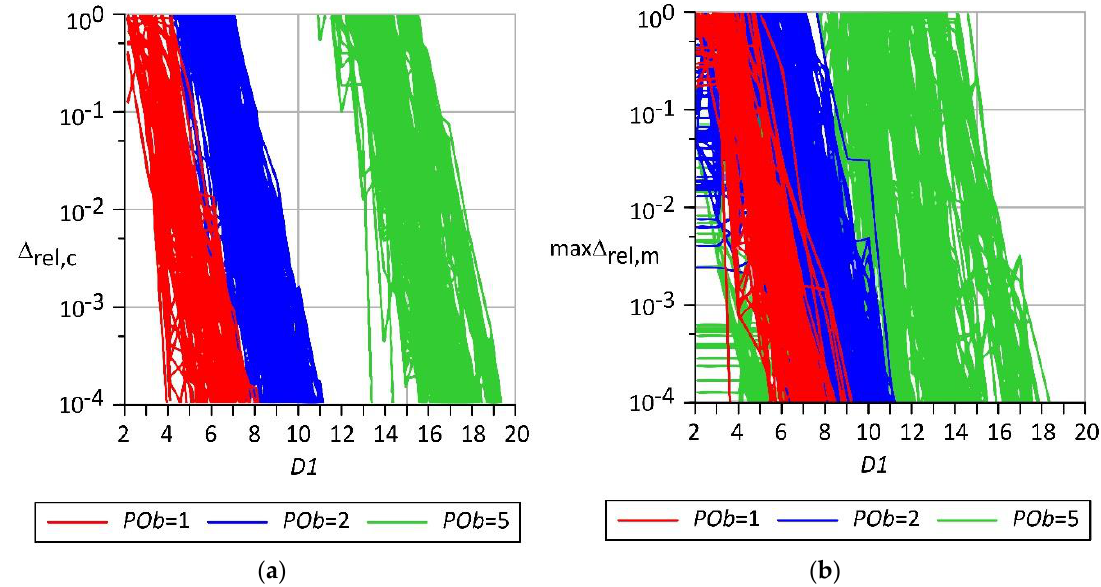
Figure 7. Comparison of the approximation accuracy criteria for all the groups of functions, its various base POb and the number of significant digits of rounding D1 : ( a ) the maximum relative error of the base polynomial coefficients Δ rel,c , ( b ) the maximum relative error of the probabilistic moments max Δ rel,m for α max *( x ) = 0.30.